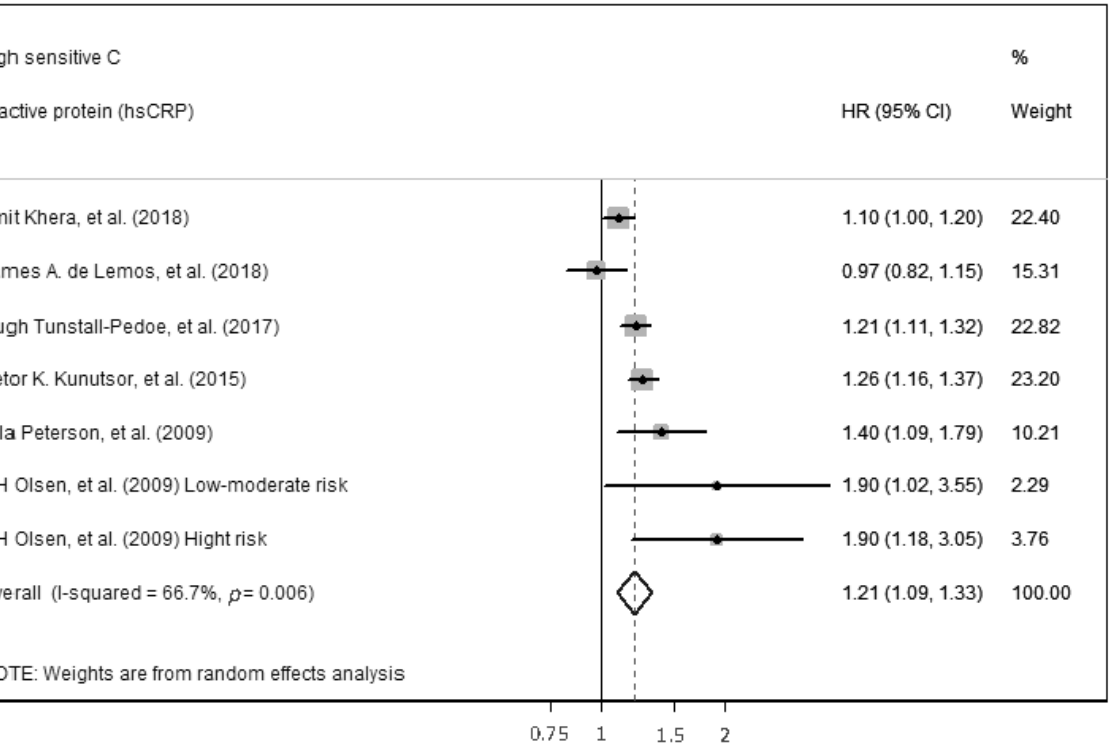
Figure 3. Forest plot of sensitivity analysis of studies for hs-CRP prediction of CVD among middle- aged adults without a prior CVD history or symptoms [16,19,20,26,38,39].